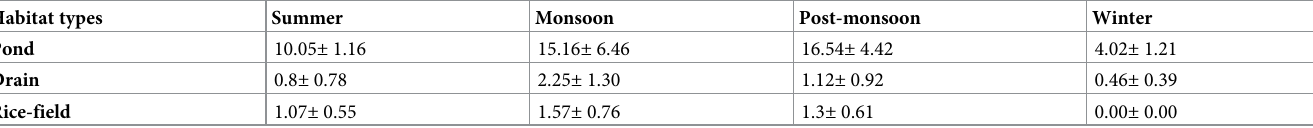
Table 1. Seasonwise per-dip larval density (Mean ± S.D) of Anopheles subpictus in different breeding habitats (March 2017-February 2018). Habitat